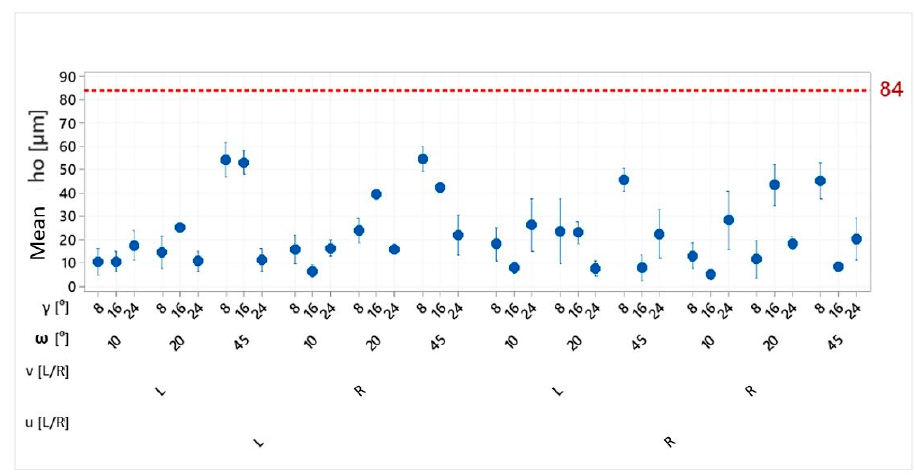
Figure 7. Results of measurements of the h 0 value of holes made with a modified drill.